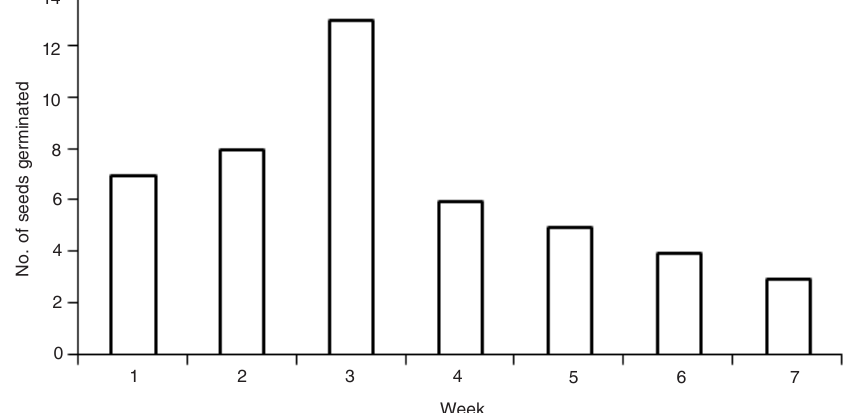
Figure 3. Seed germination rate of Decalepis hamiltonii in experimental